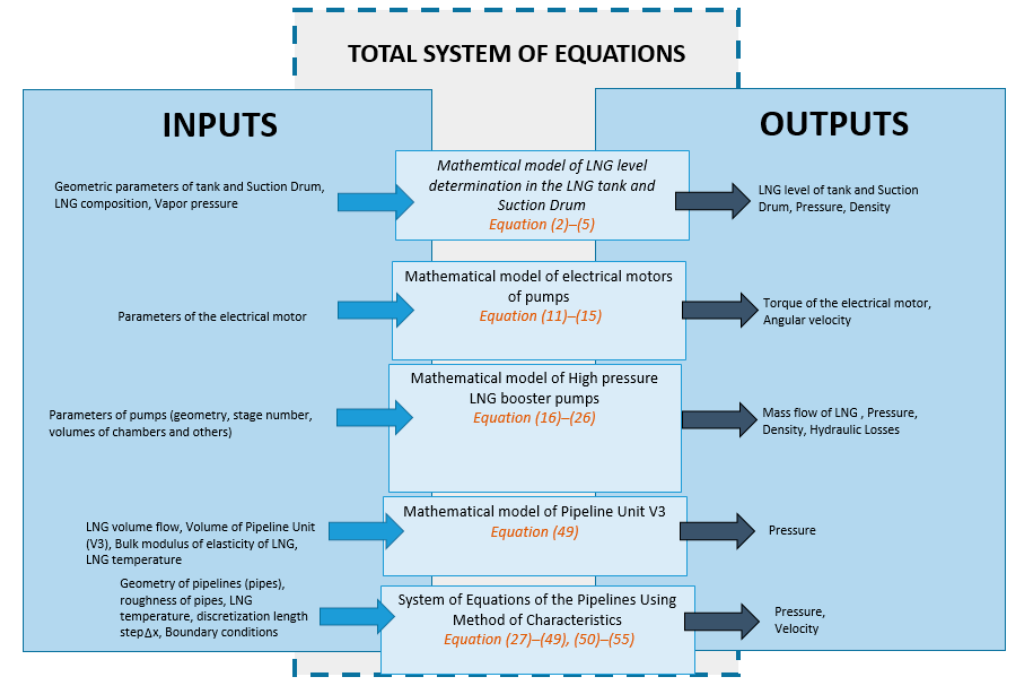
Figure 2. Principal scheme of the mathematical